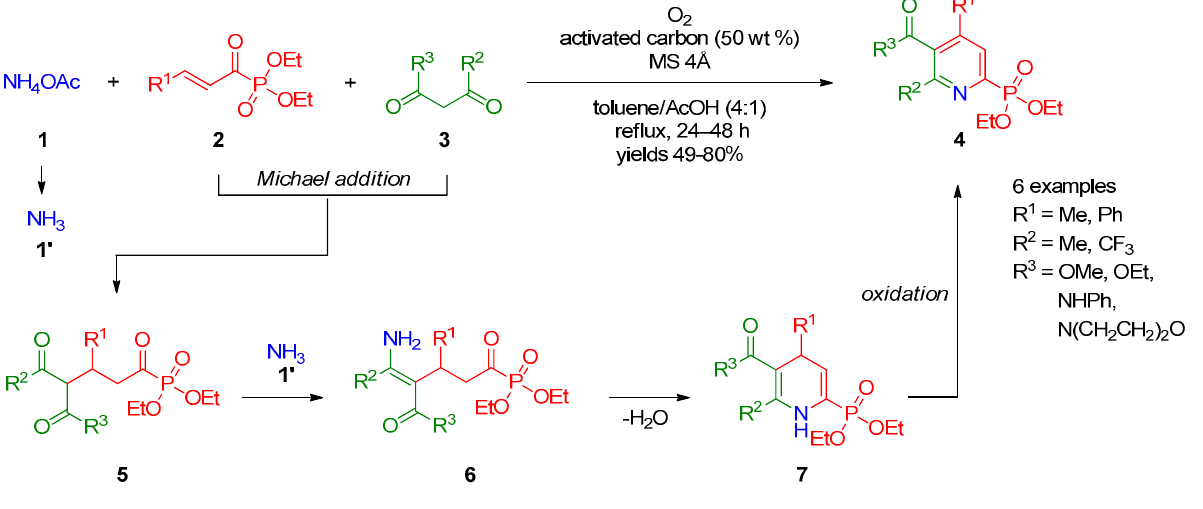
Figure 1. Approaches to synthesis of POR 2 -containing pyridines.